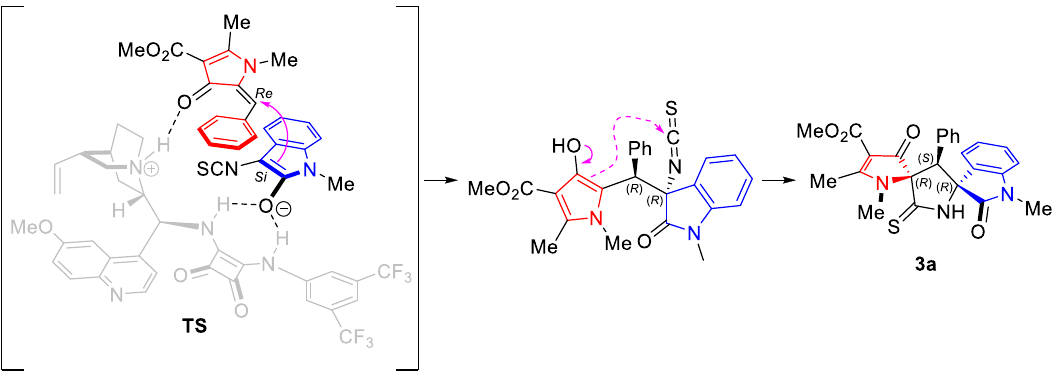
Figure 3. Single crystal X-ray structure depicting product 3b . Thermal ellipsoids are shown at 50%